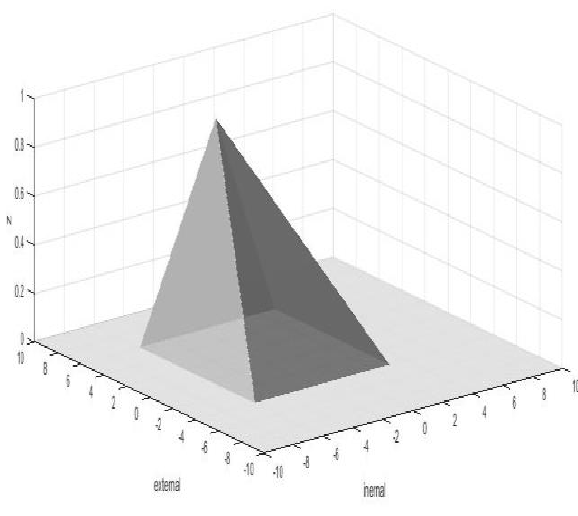
Figure 11. Aggregation result of I11 and E1 factors.